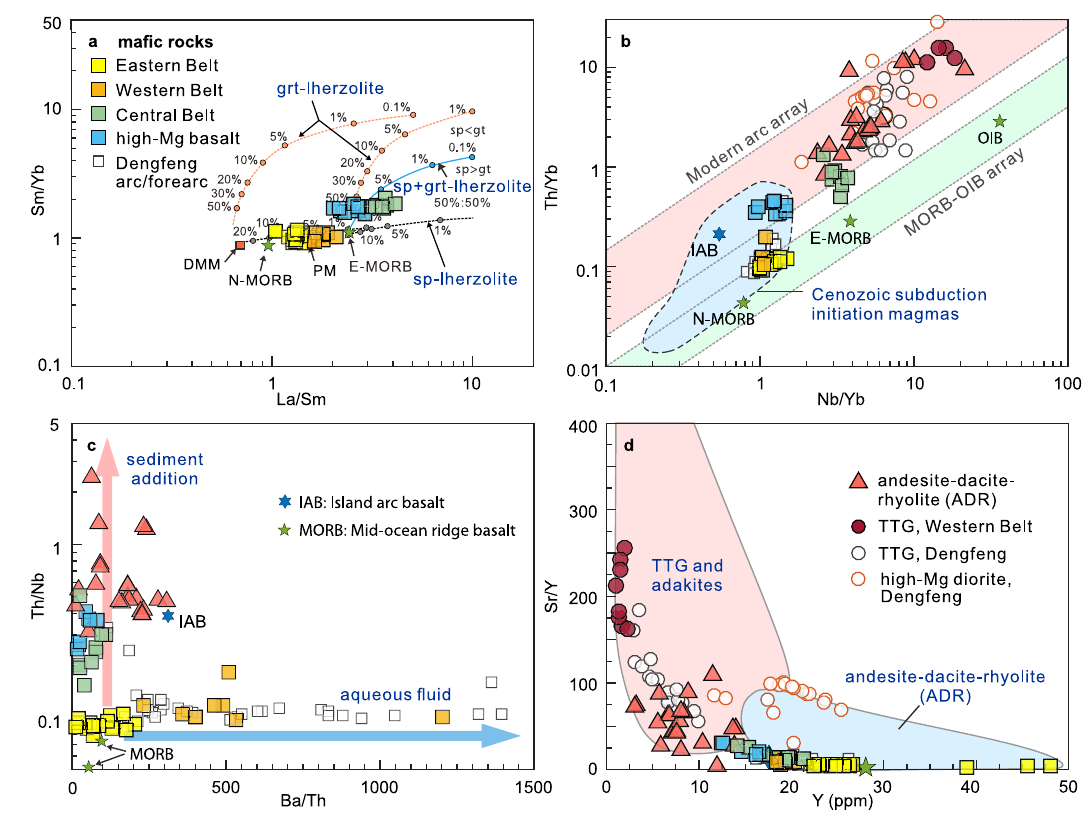
Fig. 3 | Trace element plots distinguishing magma sources and tectonic set- tings. a Sm/Yb versus La/Sm 71 . b Th/Yb versus Nb/Yb 72 . Data sources for Cenozoic subduction-initiationmagmasarethesame asref.29. c Th/NbversusBa/Th. d Sr/Y